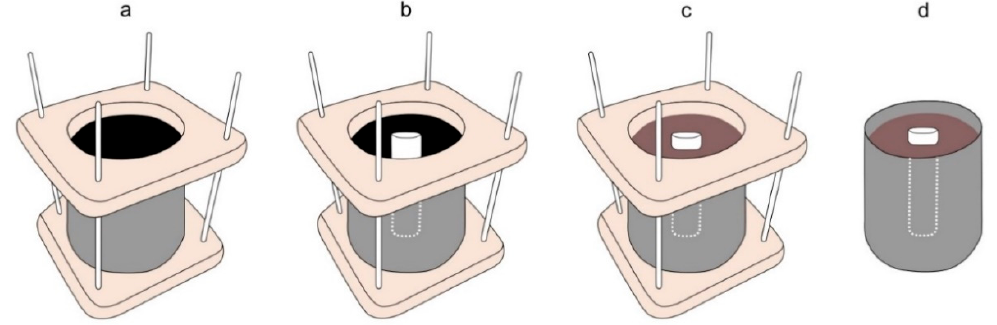
Figure 1. The process to fill the monoliths with sieved soil. ( a ) PVC pipe with a wood, rigid structure; ( b ) axial insertion of probe access tube; ( c ) soil sampler filled with the requested amount of wet soil after compaction; ( d ) monoliths ready for monitoring soil water content (U), scaled frequency value (SF), and soil bulk density ( ρ b ).